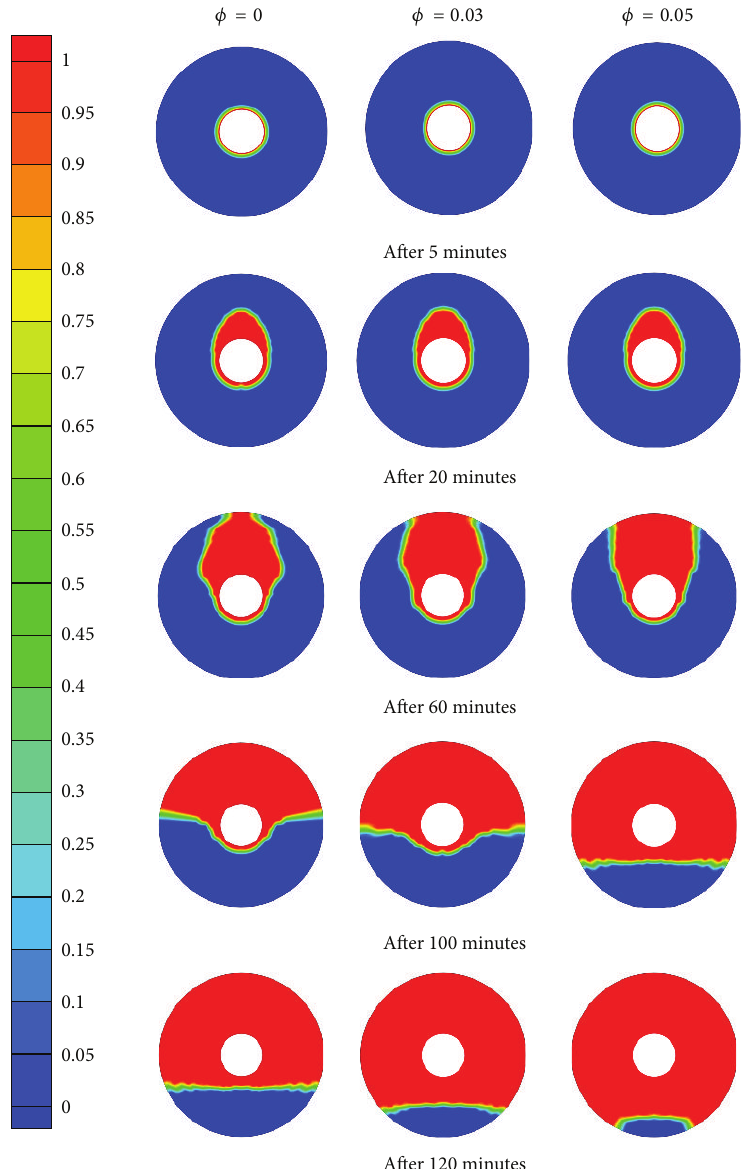
Figure 4: Liquid fraction distribution for various volume fractions of nanoparticle in midway along the length of cylindrical shell container.